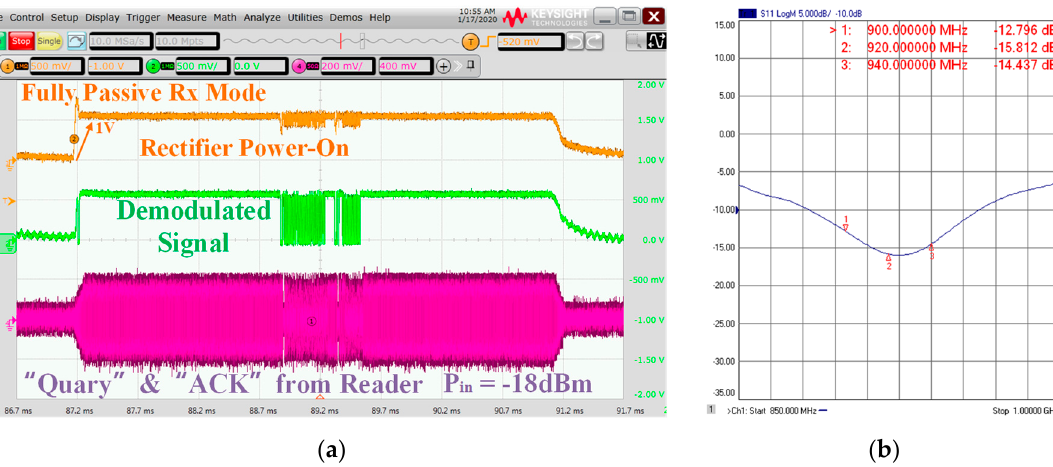
( b ) Figure 19. ( a ) Measured input signal and demodulated signal in HS mode; ( b ) bit error rate (BER) in HS mode. The power consumption of each block is shown in Figure 20. The receiver’s total power consumption were 230 nW and 880 nW for LP mode and HS mode, respectively. The energy harvester could provide more than 1 μ W of energy in an indoor environment according to the measurement resulted, so the energy was sufficient to the dual-mode receiver. 0.000010.00010.0010.01 0.11 -43